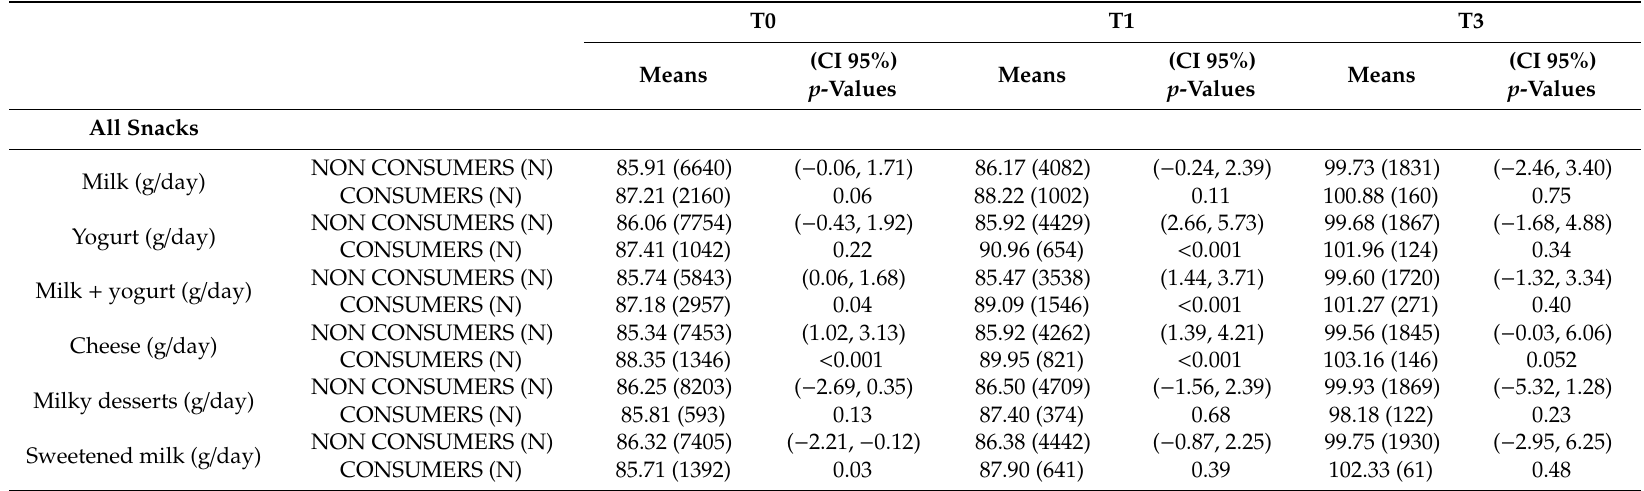
Table 4. DQI by non-consumers and consumers of the di ff erent dairy products considering all snack meal occasions, cross-sectional analyses in T0 and T1.